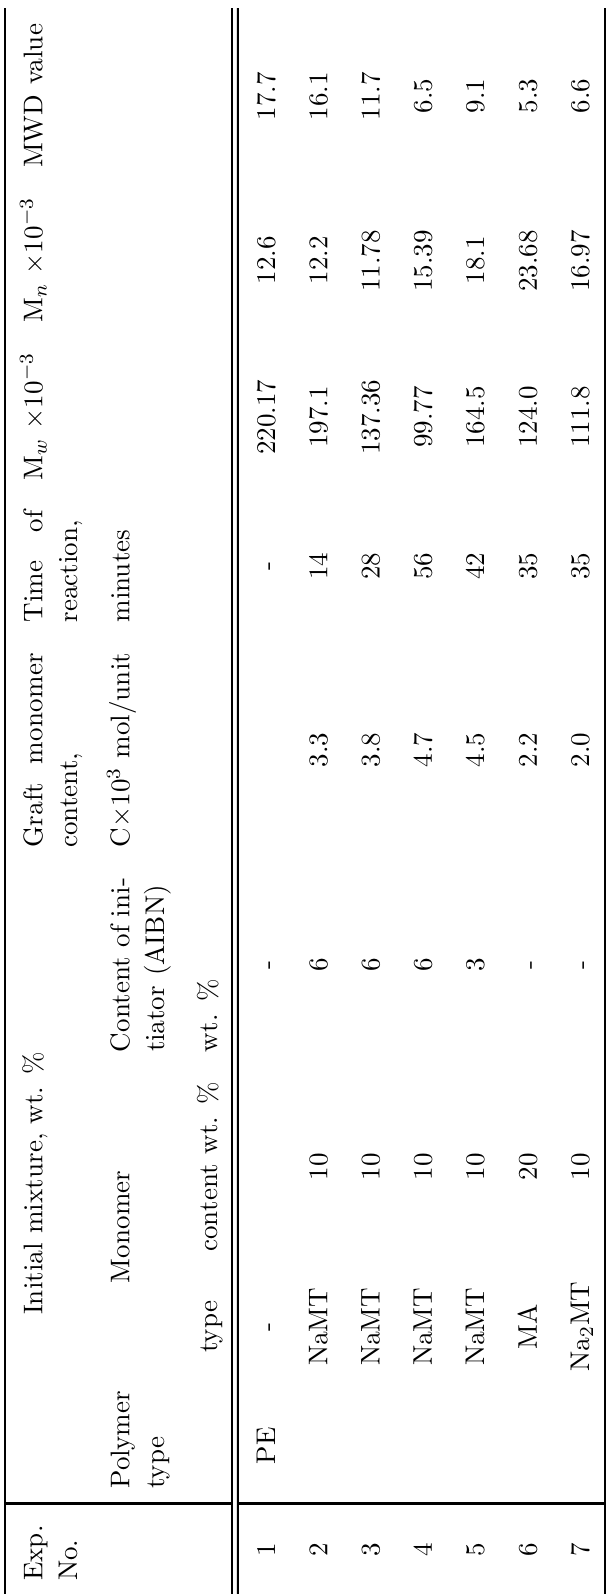
Table 2 The data on the investigations of PE in the ortodichlorbenzene solutions by the method of GPC (140 C, C = 0.05 wt.